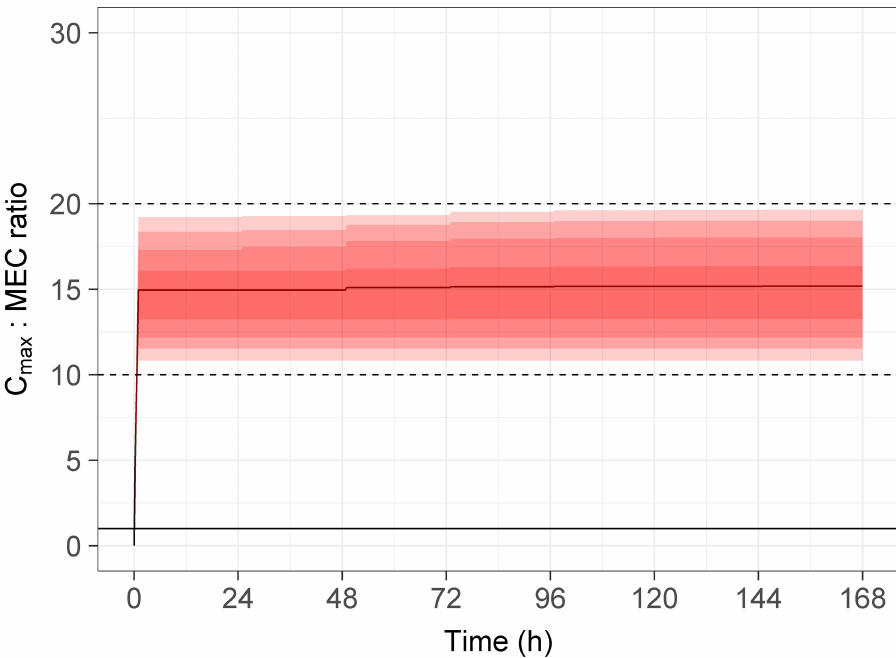
Fig 4. Plots of caspofungin C max :MEC ratio over time utilising a 1mg/kg loading dose on day 1 followed by 0.75 mg/kg daily thereafter. Red solid line indicatesthe median, shadedribbons show the 95%, 90%, 75% and 50% CI’s in increasingly dark shading. Dashedblack lines show the putative upper and lower C max :MEC ratio